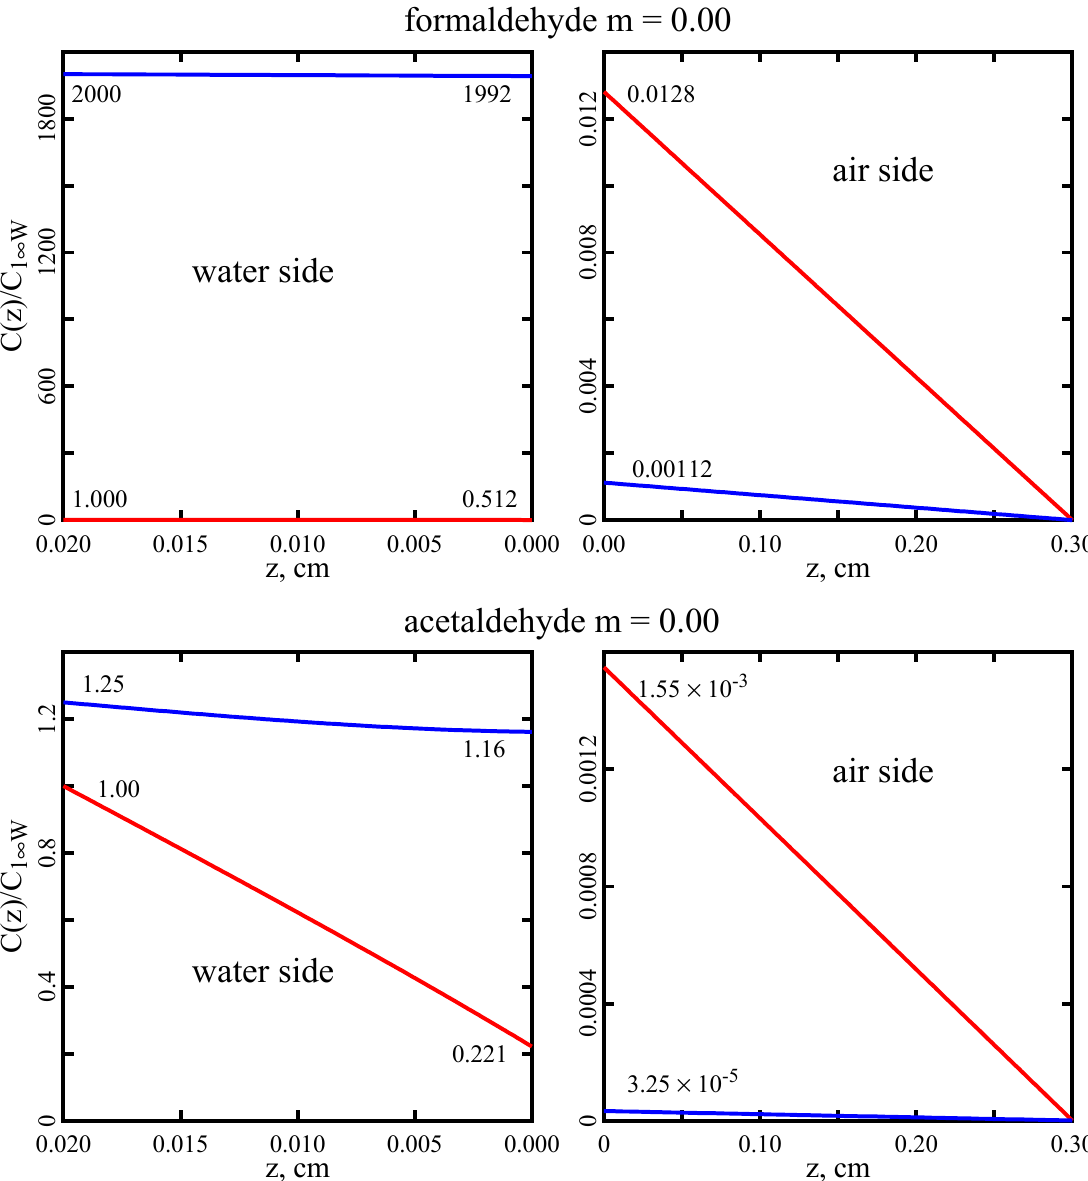
Figure 5. Concentration profiles through the films as calculated in model A4 with m = 0 and corresponding to the calculations summarized in Table 6. All concentrations are normalized to C 1 ∞ W = 1. Red = aldehyde concentration, blue = diol concentration. Intercepts at z = 0 and L are shown.